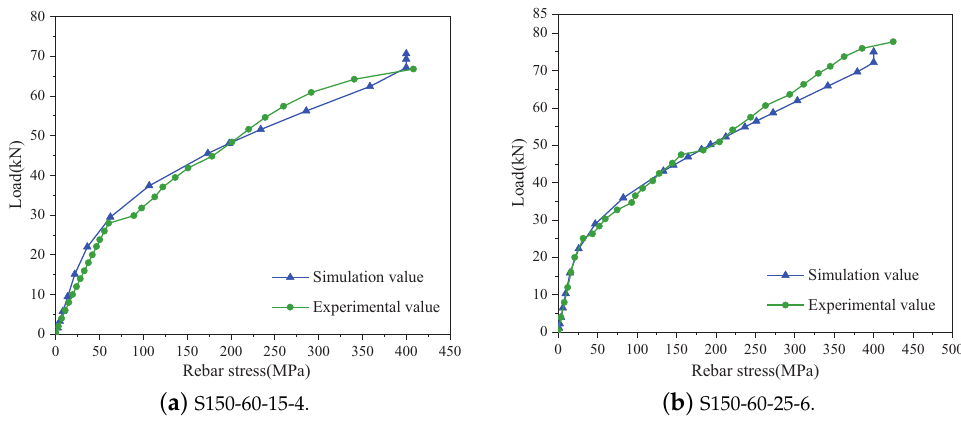
Figure 13. Load-rebar stress curve for composite beams.